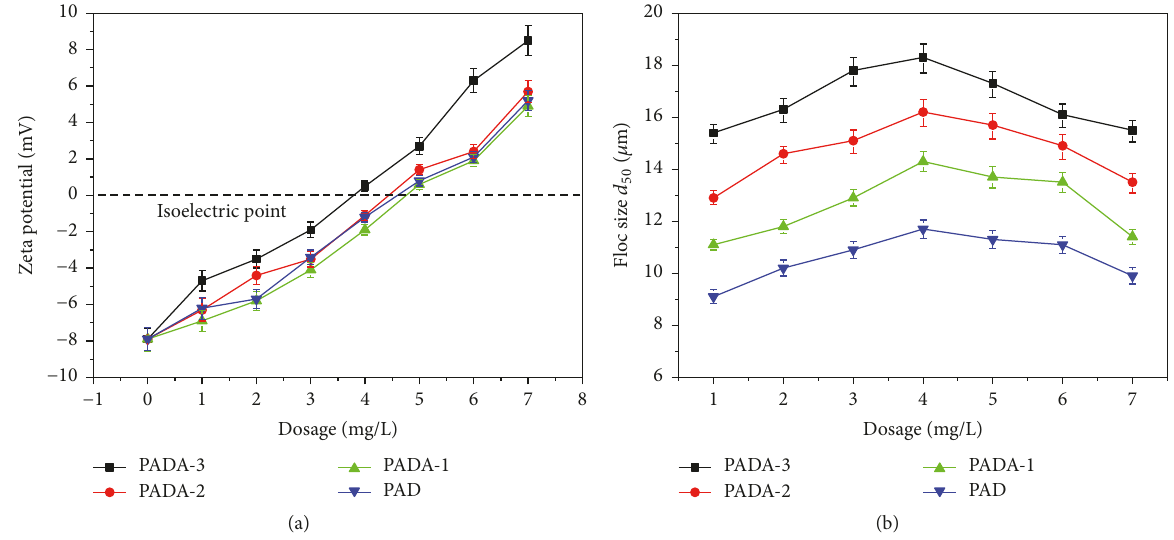
Figure 11: The zeta potential (a) and floc size (b) of the flocculants.